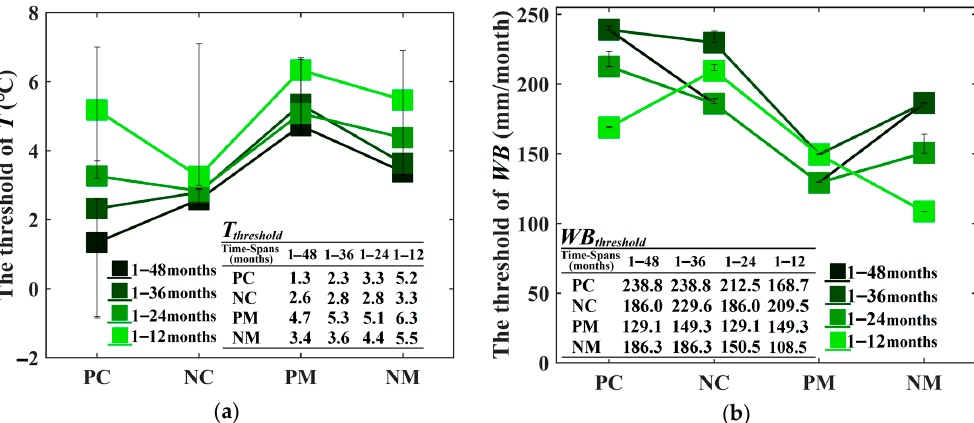
Figure 10. The ( a ) temperature thresholds and ( b ) water balance thresholds for different time-scales’ Standardized Precipitation Evapotranspiration Index ( SPEI ). The PC, PM, NC, and NM represent planted coniferous, planted mixed, natural coniferous, and natural mixed forests, respectively. The thresholds of environmental temperature ( T threshold ) and water balance ( WB threshold ) for 1–12, 1–24, and 1–36 month time scales were acquired by the same method as that used for 1–48 time scales, which were described in Section 2.3. The whiskers of the point are the actual value of T or WB around each threshold (detailed information can be found in Table S3), and their value depends on the distribution of actual data of samples.